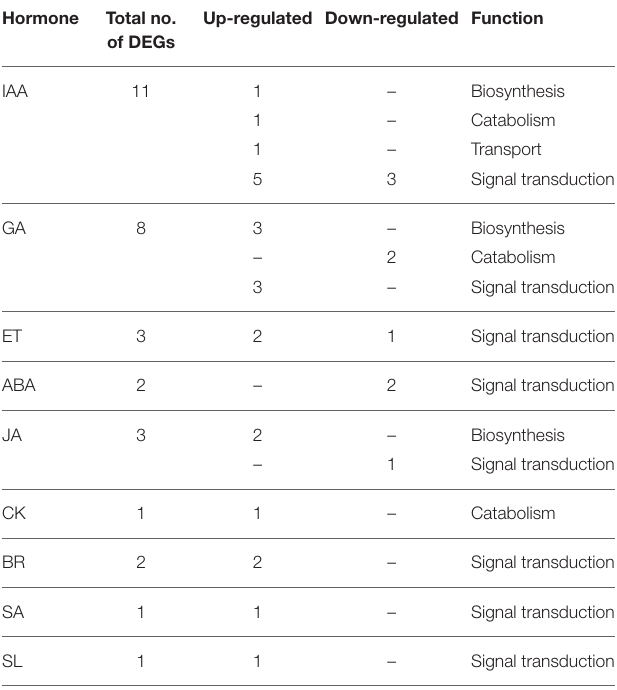
TABLE 3 | Differential expression patterns of plant hormone metabolism and signaling-related genes in comparison of libraries FAB vs. FNAB. Hormone Total no. of DEGs